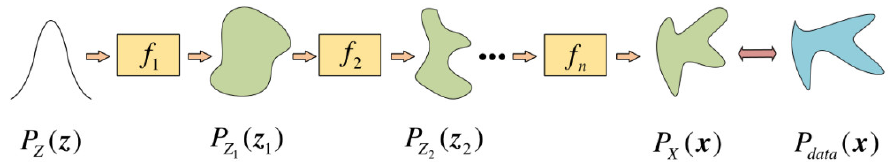
Figure 1. Structure of the flow model.